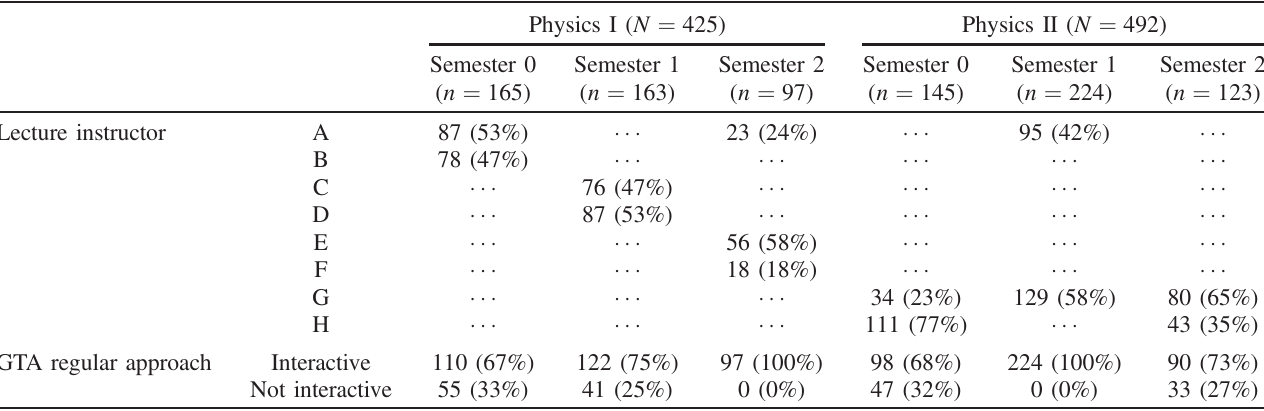
TABLE VII. Number of undergraduate student participants in each condition. The percentage is out of the total number of participants in each semester. We only included students if their GTAs were also participants in order to explore the correlation between the GTA instructional approach and student learning outcomes. Students who did not submit either pretest or posttest were not